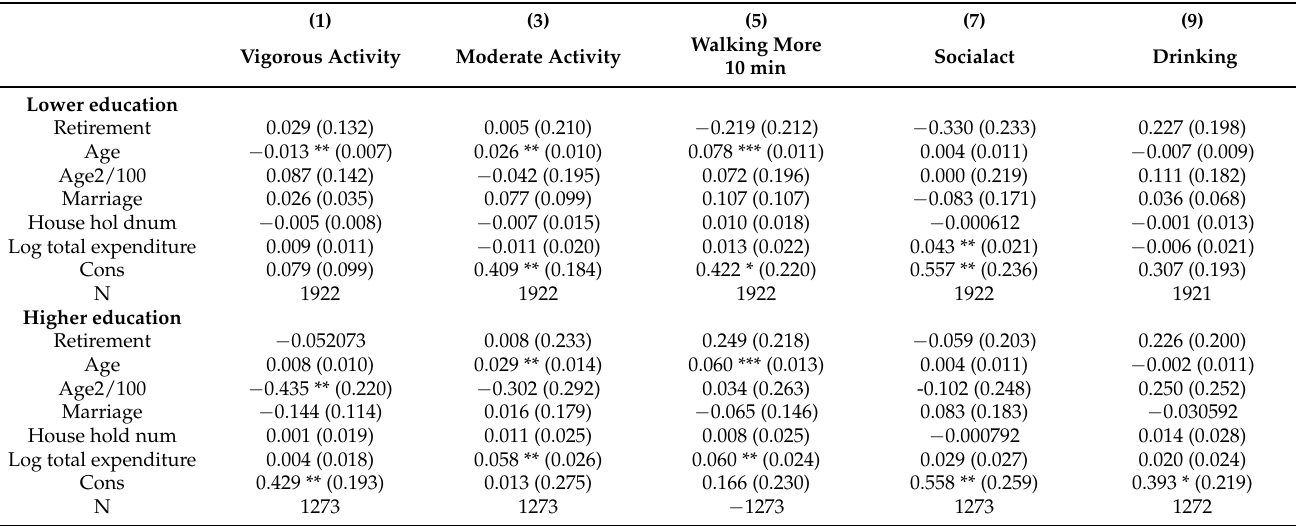
Table A7. Effect of retirement on health behaviors by education.